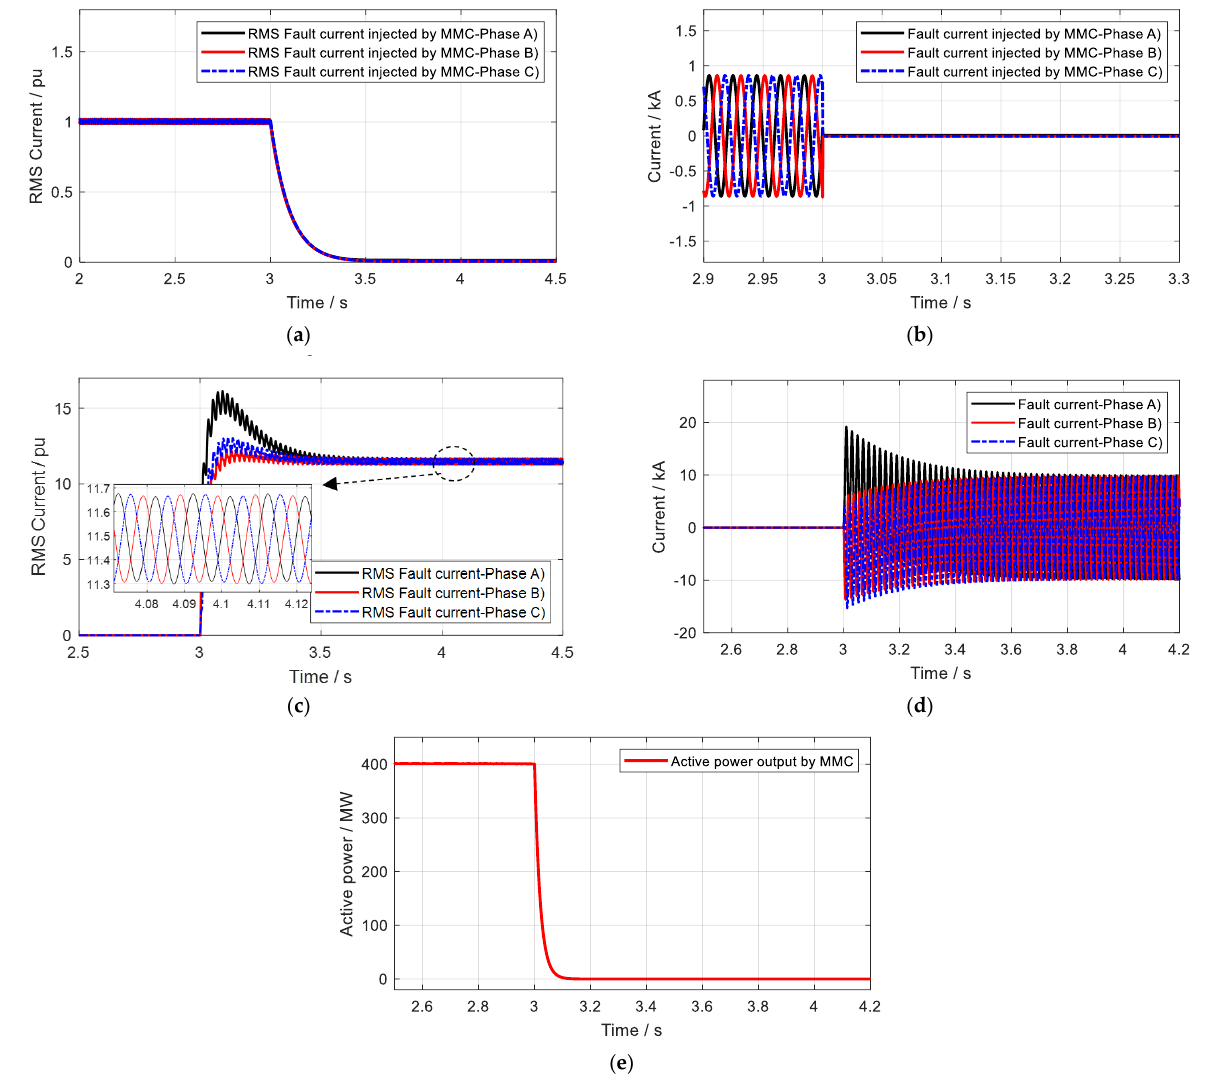
Figure 11. The simulation situations in case 1. ( a ) The RMS short-circuit current injected by the MMC after the fault. ( b ) The instantaneous short-circuit current injected by the MMC after the fault. ( c ) The RMS short-circuit current of the whole system after the fault. ( d ) The instantaneous short-circuit current of the whole system after the fault. ( e ) The active power transmitted by the